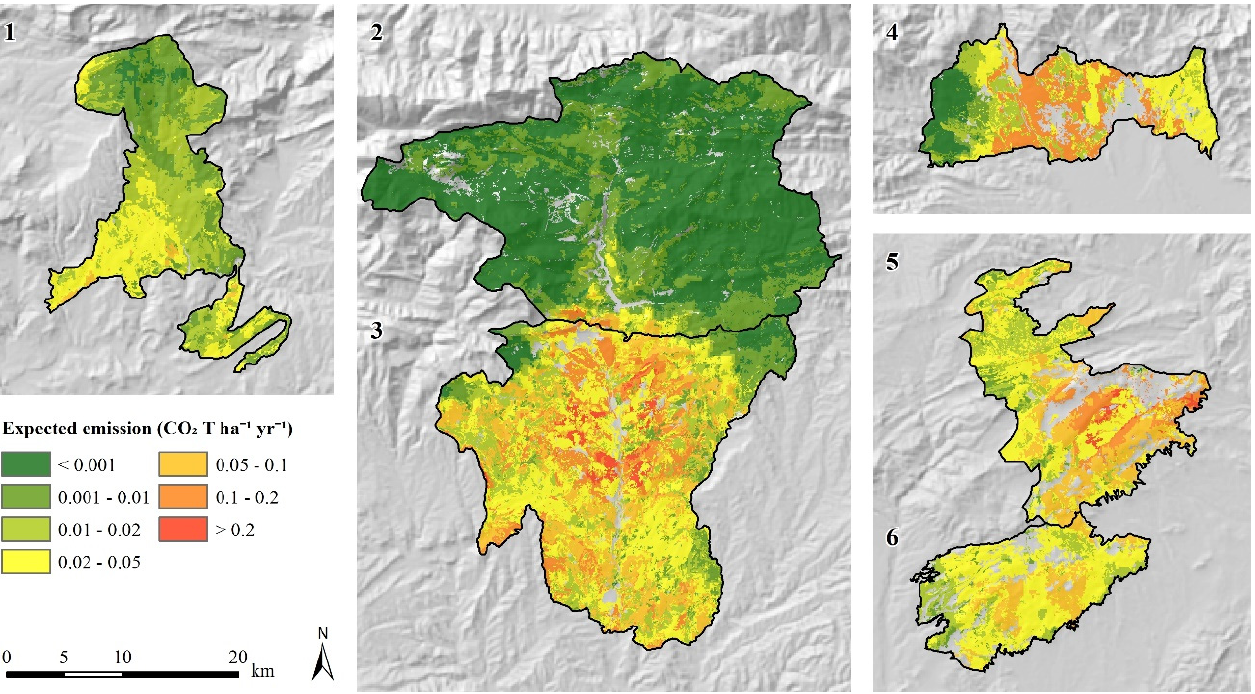
Figure 4. Expected carbon dioxide emissions (CO 2 T ha − 1 yr − 1 ) from wildfires occurring under extreme fire-weather conditions within the different planning areas. The numbers refer to the planning area codes (Appendix A; Figure